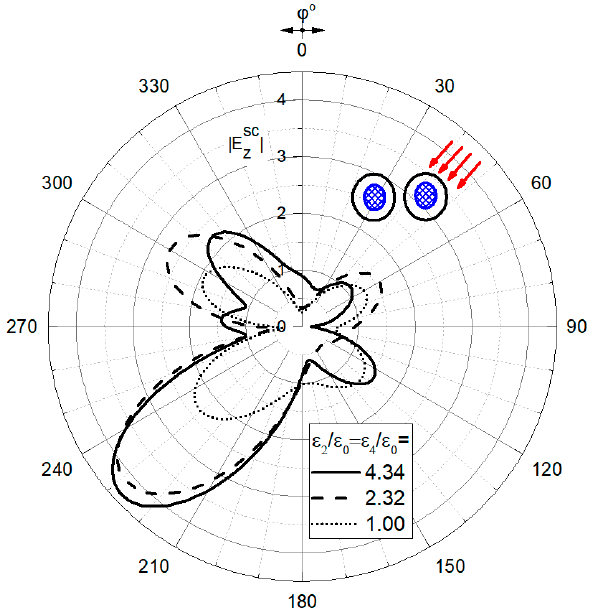
=ϕ Figure 5. The far electric field pattern ( ϕ = ϕ 1 ) for the inset structure, arising from that of Figure 1 when Figure 5. The far electric field pattern ( 1 φ ) for the inset structure, arising from that of Figure 1 L = 3, D 23 = λ 0 , ε 1 = ε 0 , α 2 = α 4 = 0.3 λ 0 , ε 3 = ε 5 = 9.6 ε 0 , α 3 = α 5 = 0.1 λ 0 , ε 2 = ε 4 = ε 0 , 2.32 ε 0 , 4.34 ε 0 , when L = 3, = µ µ σ i = 0 ( i = 1,2,3,4,5), while E 0 = 1, H 0 = 0, θ (cid:48) = 60 ◦ and ϕ (cid:48) = 45 ◦ i 0 and